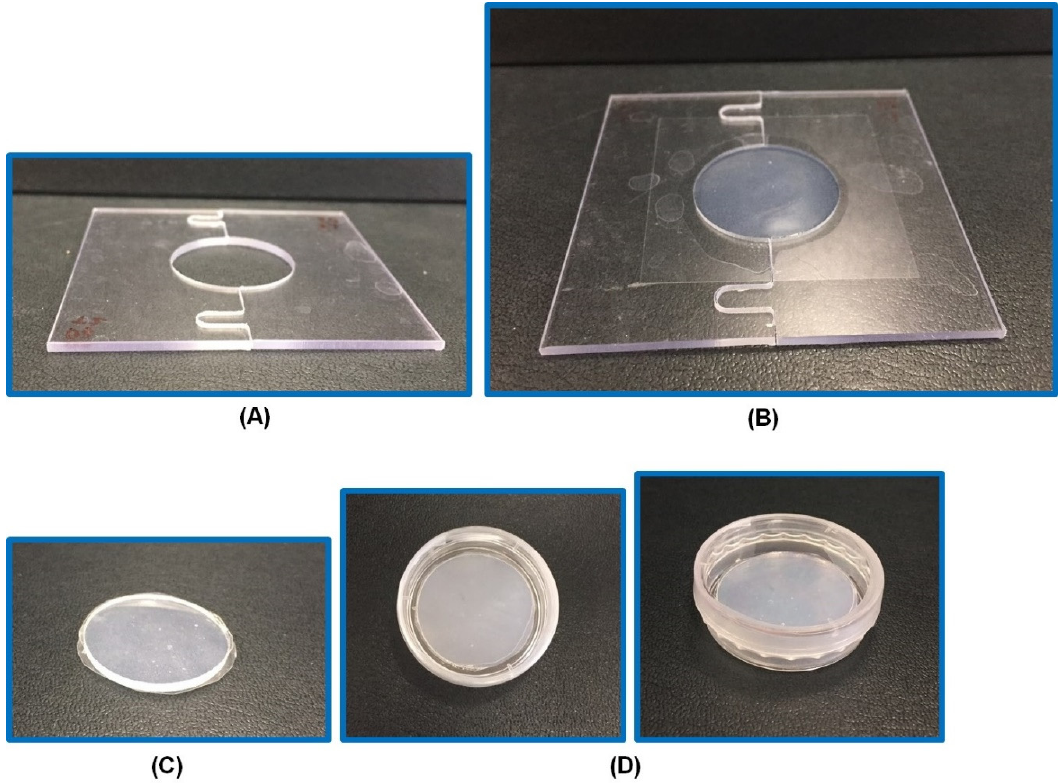
Figure 1. The specially designed mold for fabrication of circular hydrogels. A blank mold ( A ), a mold with an optimized hydrogel (26% PG [propylene glycol]-hydrogel) ( B ), 26% PG-hydrogel after its removal from the mold ( C ), 26% PG-hydrogel in a Petri dish sealed with parafilm ( D ).